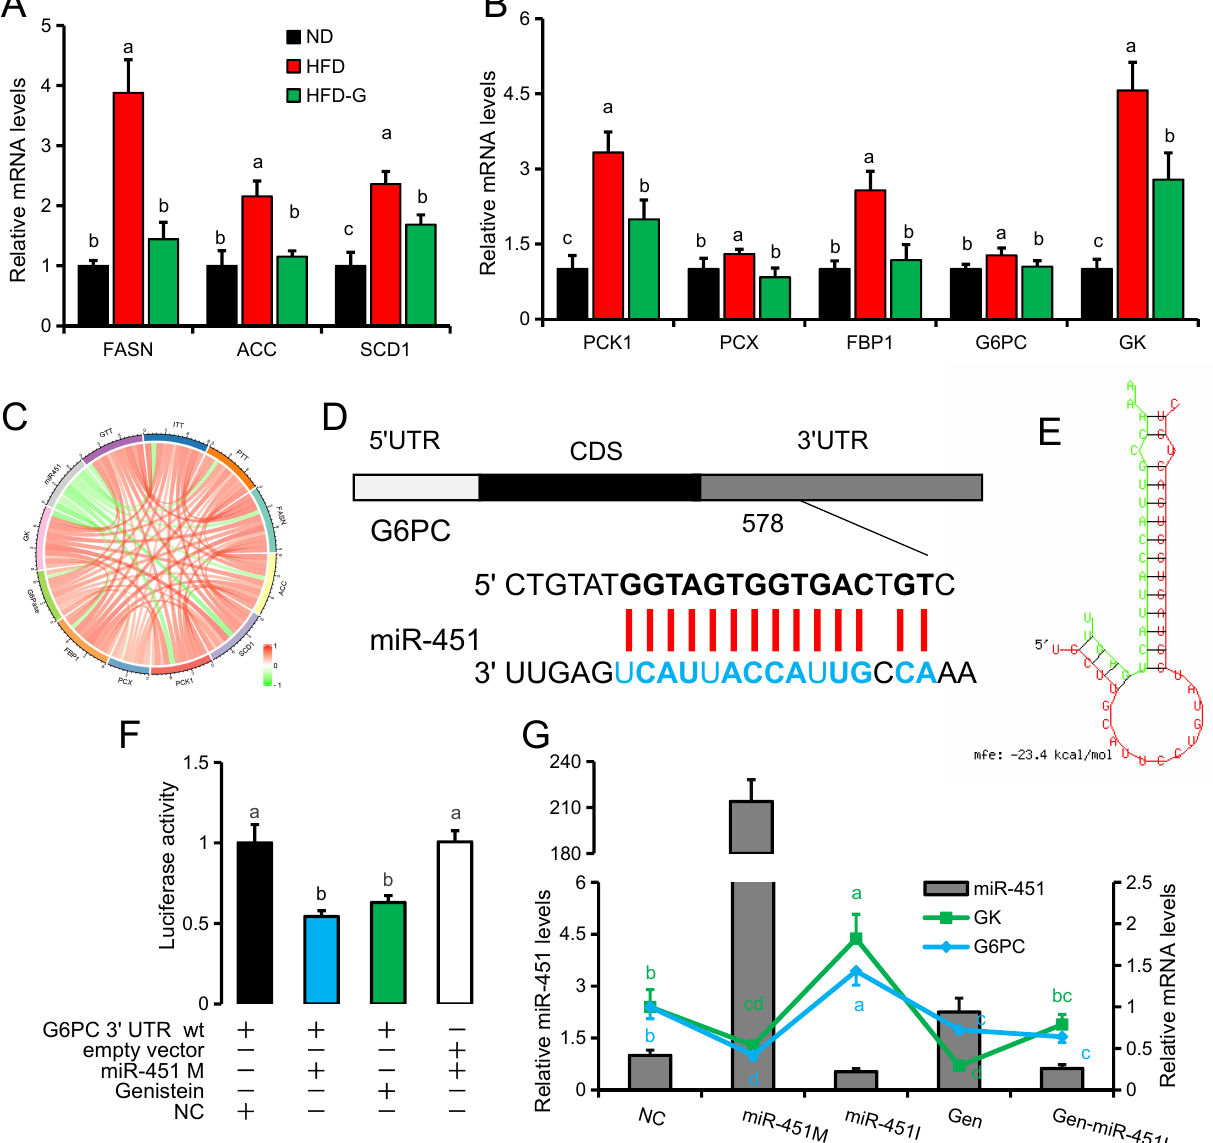
Figure 3. G6pc is a target gene of miR-451. ( A ) Expression of fat synthesis-related genes in liver, Fatty acid synthase ( Fasn ), Acetyl Co A carboxylase ( Acc1 ), Stearoyl-CoAdesaturase-1 ( Scd1 ). ( B ) Expression of gluconeogenesis-related genes in liver, pyruvate carboxylase ( Pcx ), phosphoenolpyruvate car- boxykinase ( Pck1 ), fructose-1,6-2 phosphatase ( Fbp ), and glucose-6-phosphate enzyme ( G6pc ), glycerol kinase ( Gk ). ( C ) Correlations between miR-451 and fat synthesis genes, gluconeogenesis genes, AUC- GTT, AUC-ITT and AUC-PTT. ( D ) Binding position of miR-451 to the 3 (cid:48) UTR of G6pc . ( E ) Secondary structure of the binding site of miR-451 to the 3 (cid:48) UTR of G6pc . ( F ) Fluorescence intensity of the dual-luciferase reporter assay system. ( G ) The expression of miR-451, G6pc and Gk in NCTC1469 cells after treatment with negative control (NC), miR-451 mimic (miR-451M), miR-451 inhibitor (miR- 451I), 20 µ M genistein (Gen) and 20 µ M genistein + miR-451 inhibitor (Gen-miR-451I). ( A , B ) n = 6; ( F , G ) n = 3. Different superscript letters indicate significant differences ( p ≤ 0.05), and the same superscript letters indicate insignificant differences ( p >